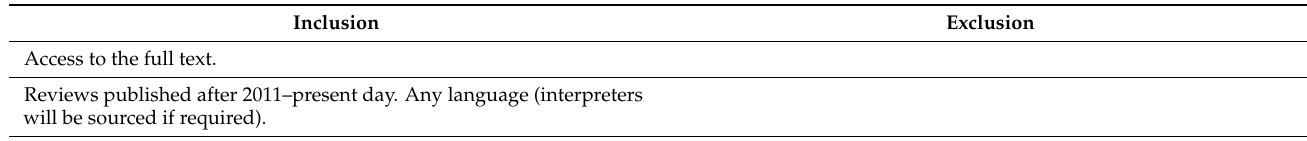
Table 2. Inclusion and exclusion